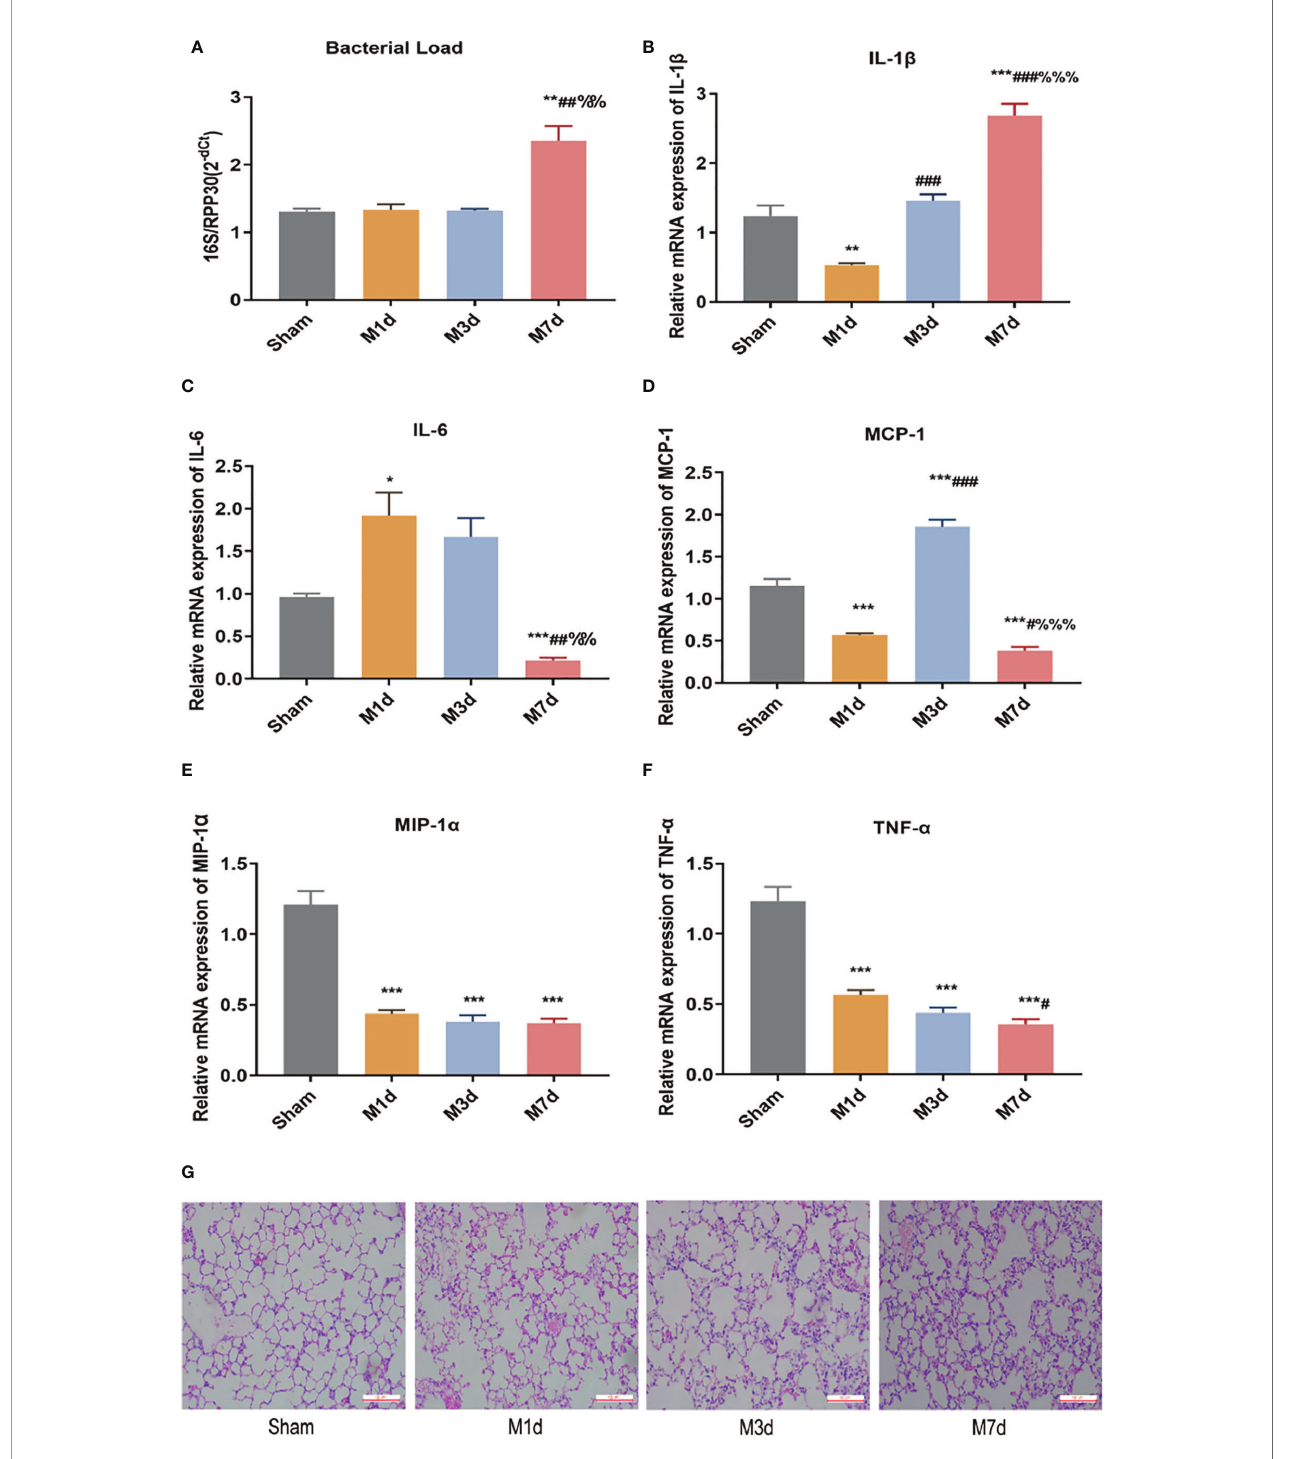
FIGURE 2 | Changes in bacterial load and in fl ammatory factor expression in lung tissues at different time points in the ICH model. (A) Real-time quantitative PCR was used to detect the lung micro fl ora load at different time points in the ICH model (n = 10). (B – F) The mRNA levels of IL-1 b , IL-6, MCP-1, MIP-1 a , and TNF- a in lung tissue from ICH model at different time points were detected by qPCR (n = 8). (G) Representative images of H&E staining of the lung at different time points in the ICH model (magni fi cation ×200). Data are expressed as the mean ± standard deviation. (A, C, D, F) Brown-Forsythe and Welch ANOVA, Dunnett ’ s T3 multiple comparison test; (B, E) One-way ANOVA, Tukey ’ s multiple comparison test; * P <0.05, ** P <0.01, *** P <0.001 vs. the sham group; # P <0.05, ## P <0.01, ### P <0.001 vs. the M 1 d group; %% P <0.01, %%% P <0.001 vs. the M 3 d